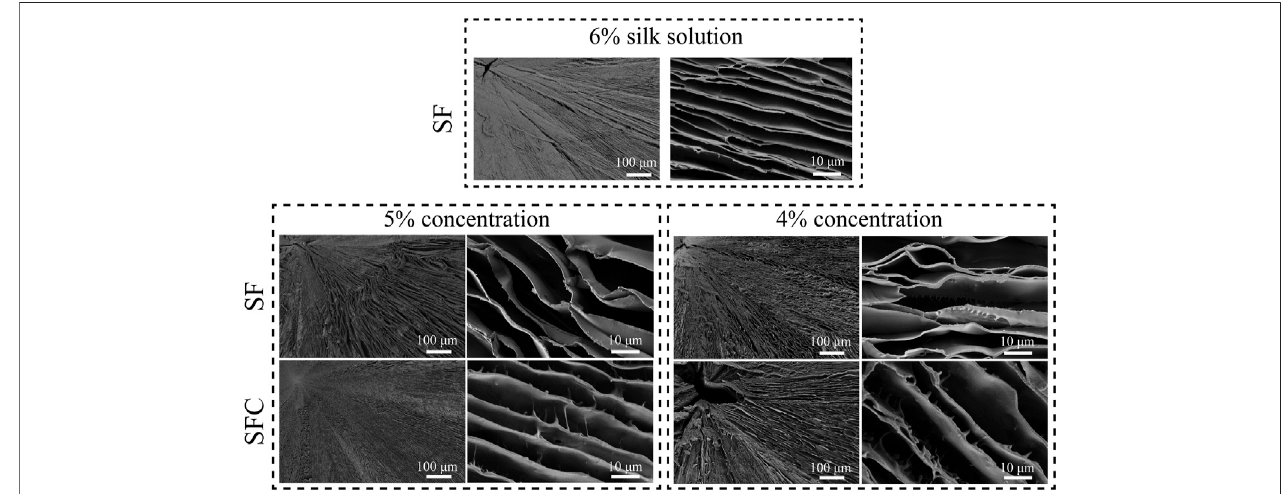
FIGURE 1 | SEM images of SF and SFC scaffolds at different concentrations (w/v).